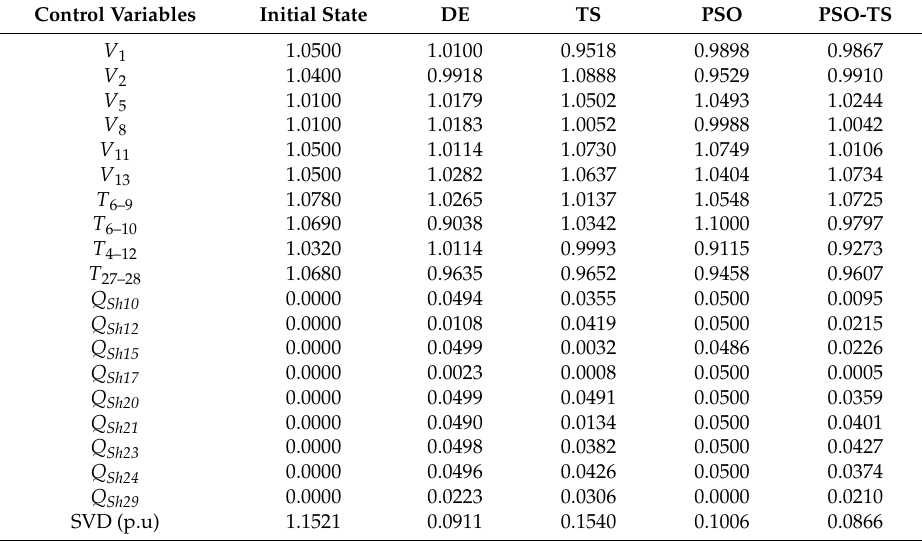
Table 5. Experimental results of TS, PSO and PSO-TS algorithms (Case